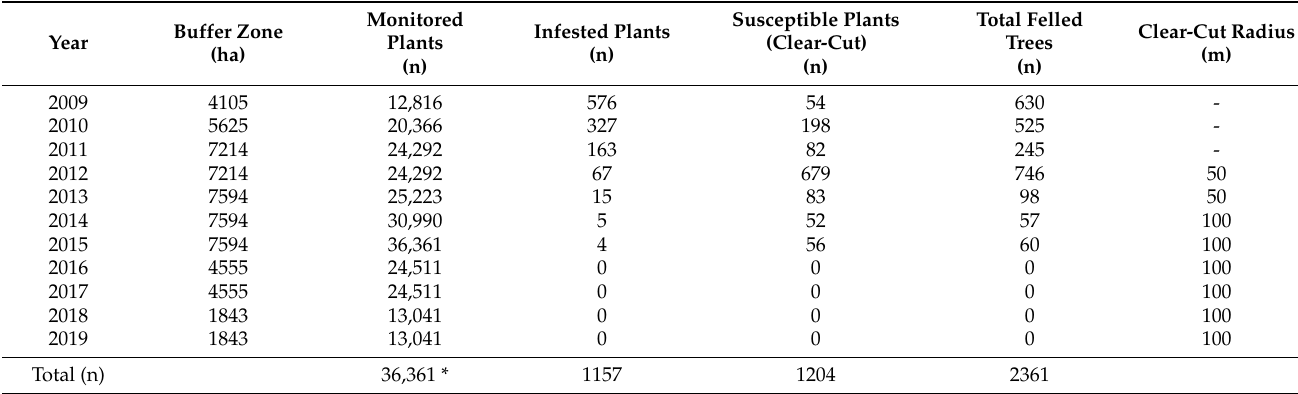
Table 3. Extension of buffer zones, number of monitored and felled trees (divided in “infested” and susceptible trees), and clear-cut radius adopted for each